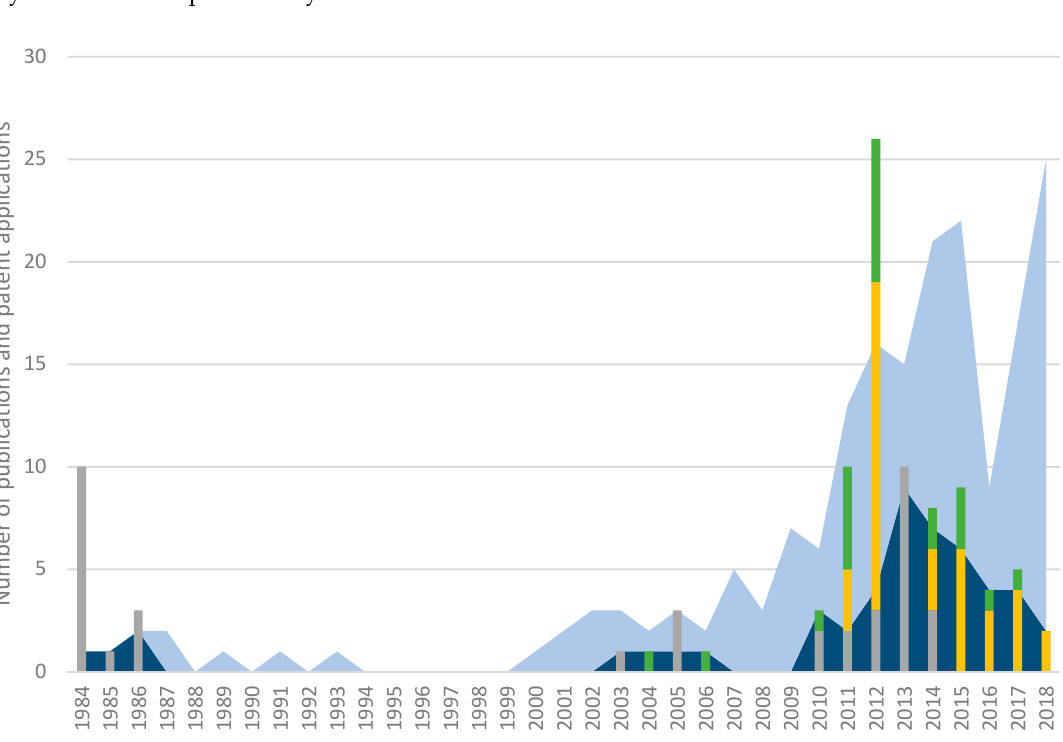
Figure 1. An overview of the number of scientific publications, patent families, patents, and patent applications in the field of phage biocontrol in crop production organized by year. The light blue area chart represents the number of scientific publications and the dark blue area chart the number of patent families per priority year. The bars represent the number of patent applications per priority year: green (“Granted patents”) corresponds to the number of granted patents, yellow (“Pending applications”) to pending applications, and grey (“Dead applications and patents”) to dead patents and applications. This last group consists of patents and applications that are abandoned, refused, withdrawn, deemed to be withdrawn, or lapsed.